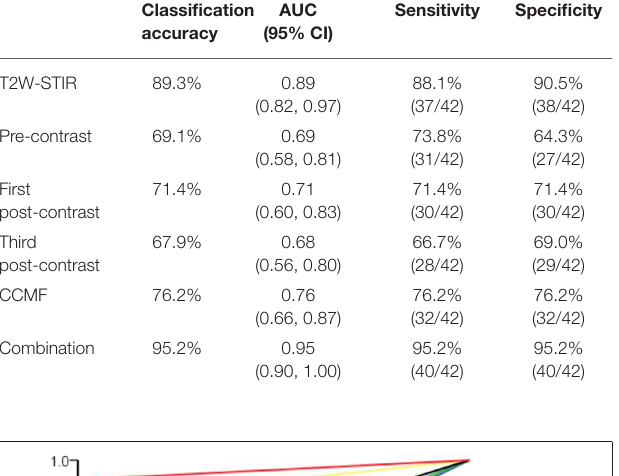
TABLE 4 | Features classification and receiver operating characteristic analysis of phyllodes tumors and fibroadenomas.